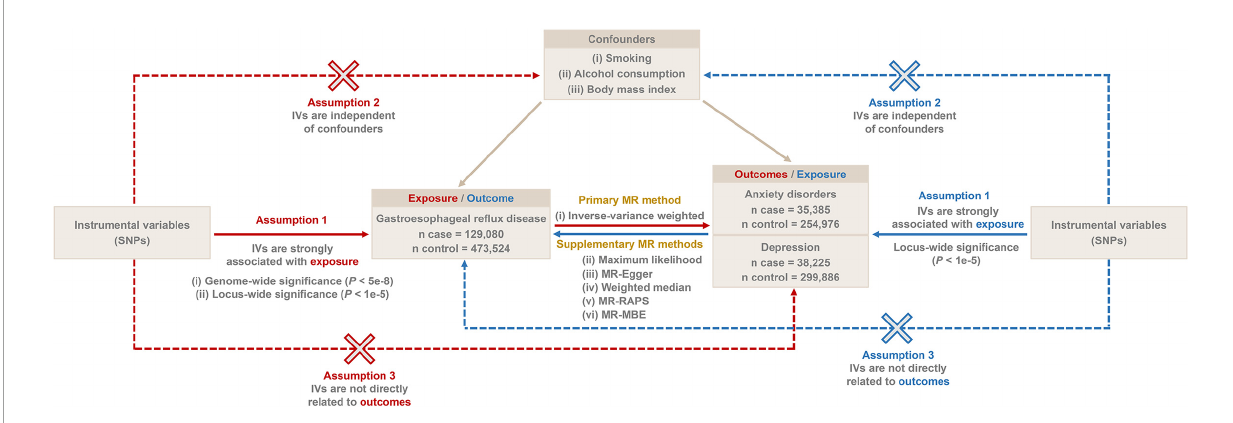
FIGURE1 The overall flow chart of bidirectional MR study. SNP, single-nucleotide polymorphism; MR-RAPS, robust adjusted profile score; MR-MBE, mode-based estimate.